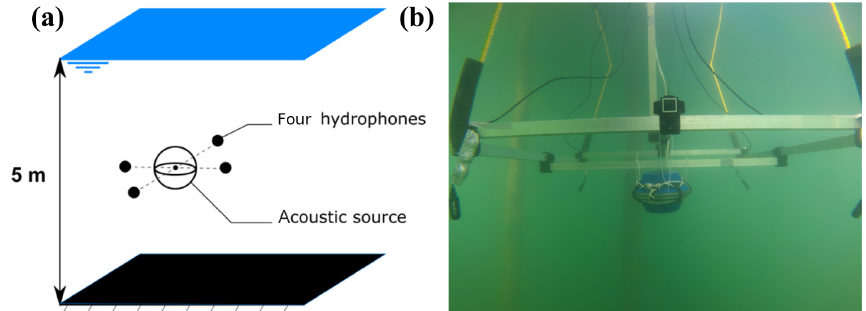
Figure 1. (a) Schematic design of the test characterizing the system of emission; (b) photography of the immersed system in Lac du Bourget (France).